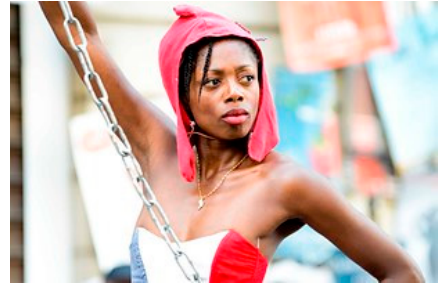
Figure 2. Maïmouna Coulibaly/¨Marianne Coulibaly.